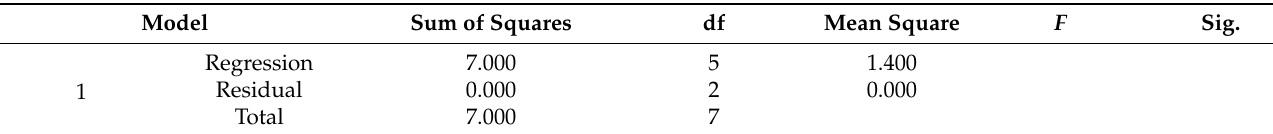
Table 16. Variance analysis principal component 1.